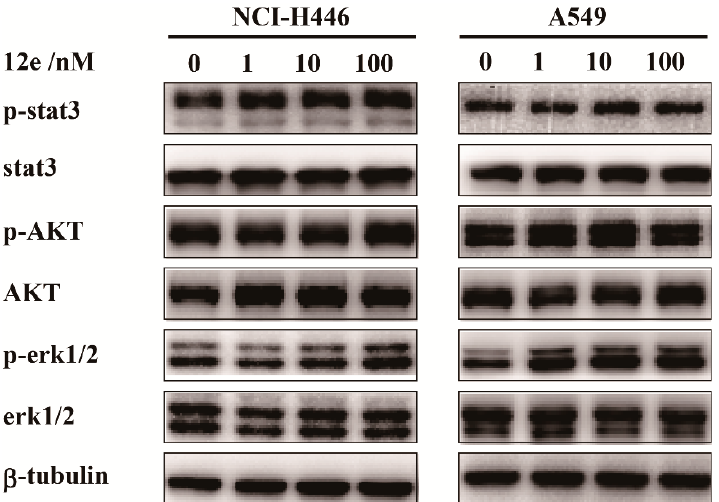
Figure 4. 12e does not impair cell proliferation upstream signaling in lung cancer cell lines. NCI-H446 and A549 cells were treated with 12e (0–100 nM) for 24 h, the levels of proliferation-related proteins were detected by western blotting. β -tubulin served as the loading control.